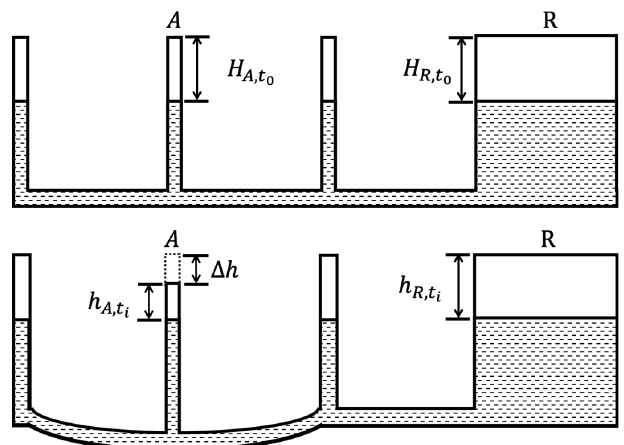
Figure 1. Fundamental principal of the connected pipe system.